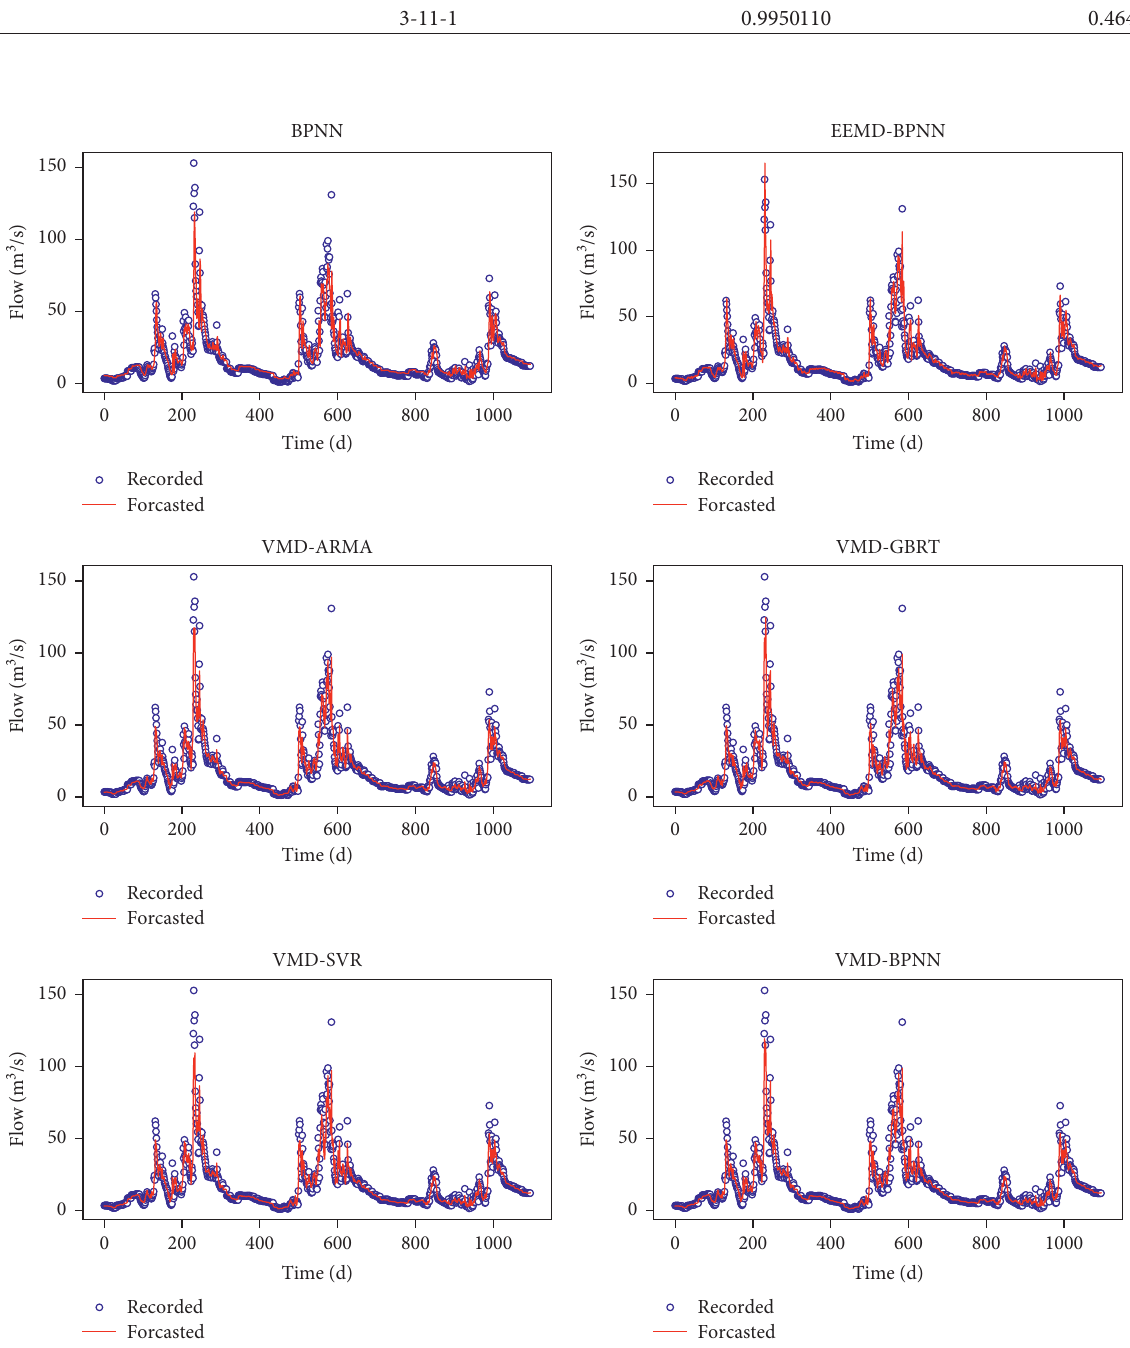
Figure 6: Comparison of the records and predicted streamflow results of the BPNN, EEMD-BPNN, VMD-ARMA, VMD-GBRT, VMD- SVR, and VMD-BPNN models during the testing phase (01/01/2012–31/12/2014) at the Wushan